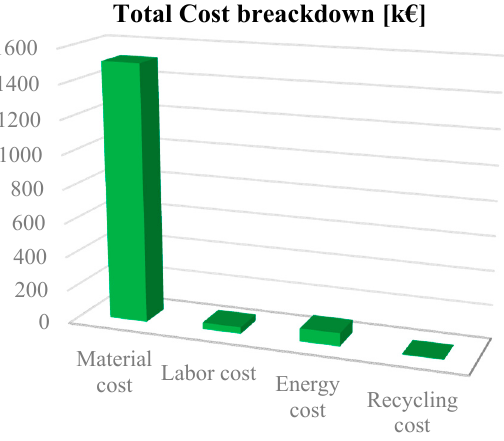
Figure 6. Total Life Cycle Costing (LCC) for the fuselage panel entire life.